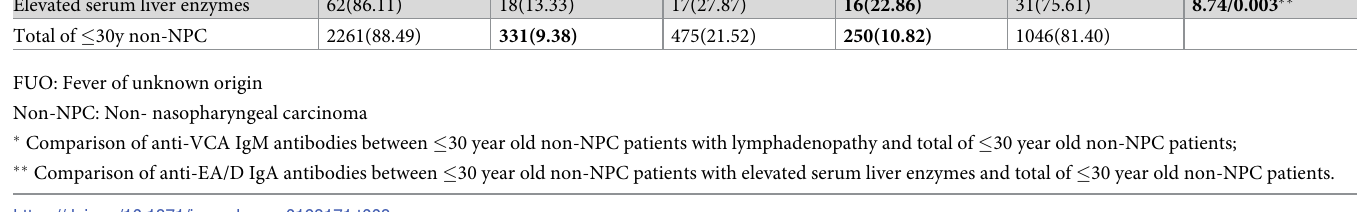
Comparisons of anti-EBV antibodies in non-NPC patients with various symptoms who were 30 years old or younger are presented in Table 3. The prevalence of VCA-IgM was found to be